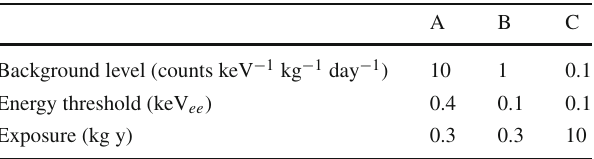
Table 6 Conditions assumed in the calculations of the TREX-DM sen- sitivity shown in figure